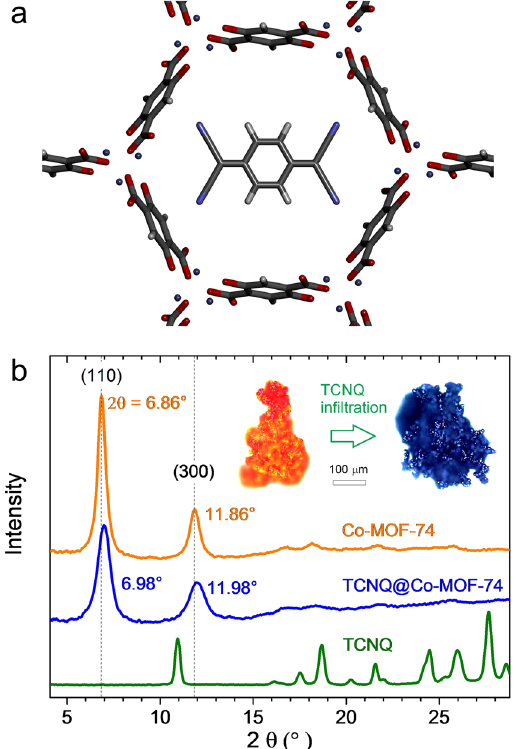
Figure 1. ( a ) A diagram of a Co-MOF-74 framework encapsulating a TCNQ molecule. ( b ) X-ray diffraction profiles of Co-MOF-74 and TCNQ@Co-MOF-74 microcrystallites in comparison to TCNQ powder. The dashed vertical lines are the first two diffraction lines expected for Co-MOF-74 18 . Inset: optical micrographs of microcrystallites before (left) and after (right) the infiltration with